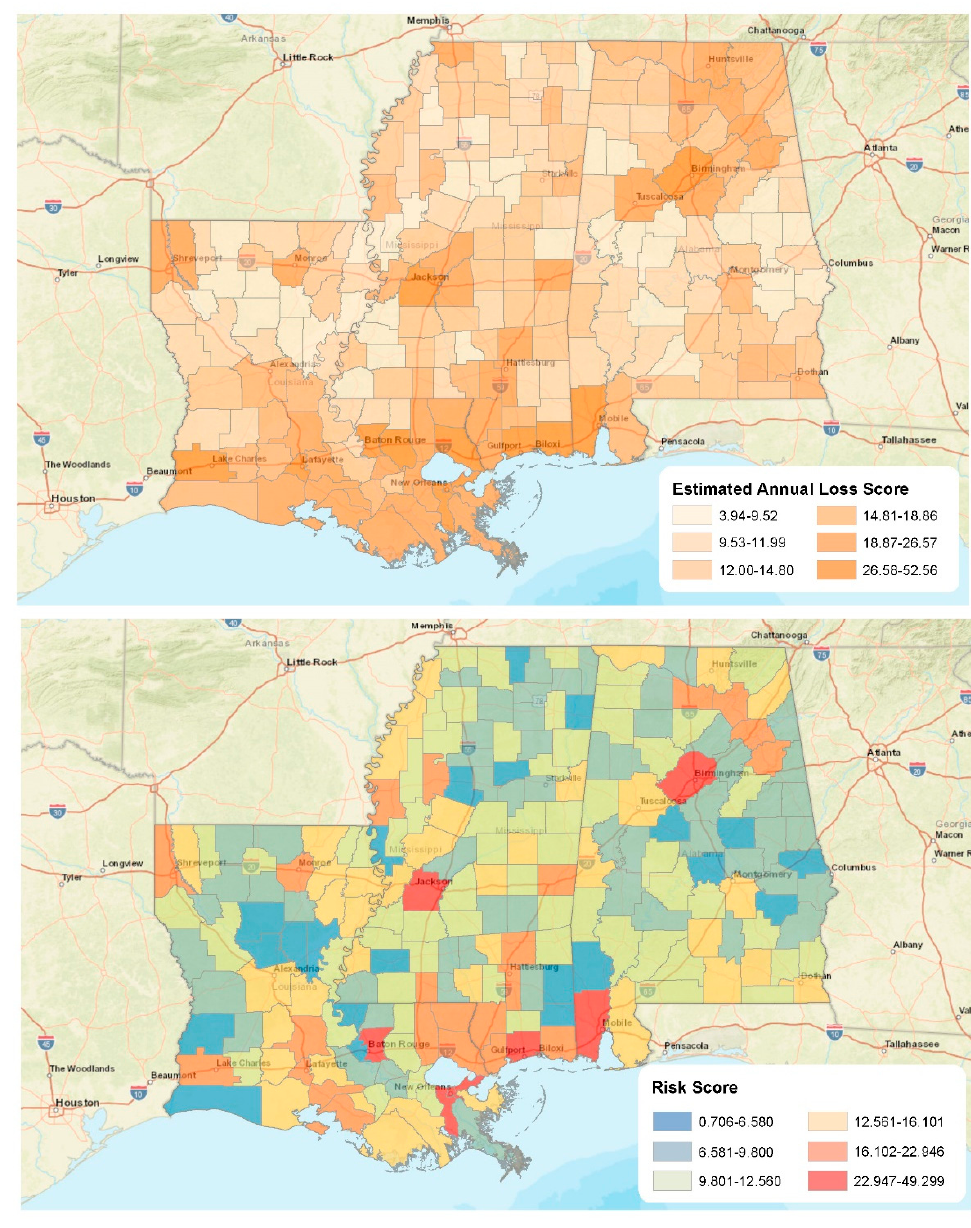
Figure 4. Expected annual loss and composite risk